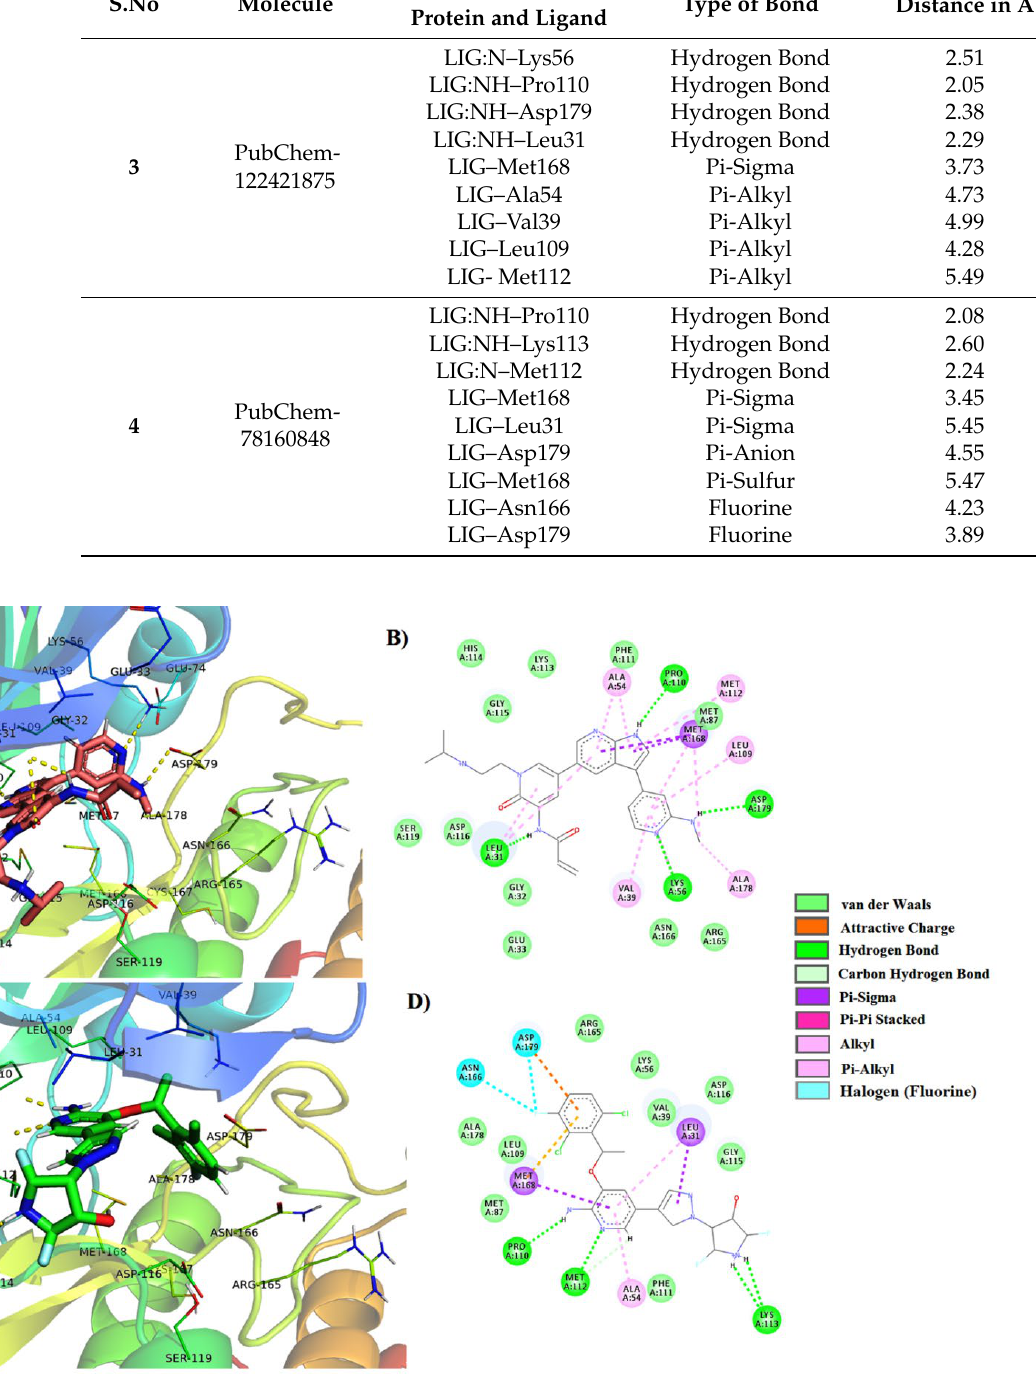
Figure 3. ( A ) Docking of the PubChem-122421875 molecule into the active site of the AXL kinase, ( B ) PubChem-122421875 molecule interaction with the AXL kinase. ( C ) Docking of PubChem-78160848 molecule into the active site of the AXL kinase. ( D ) PubChem-78160848 molecule interactions with AXL kinase. Protein amino acids are shown with lines, and ligand molecules are shown with the stick model. Table 2. Molecular docking of four selected molecules in the active site of the AXL kinase and their interactions with the AXL kinase amino acid residues.